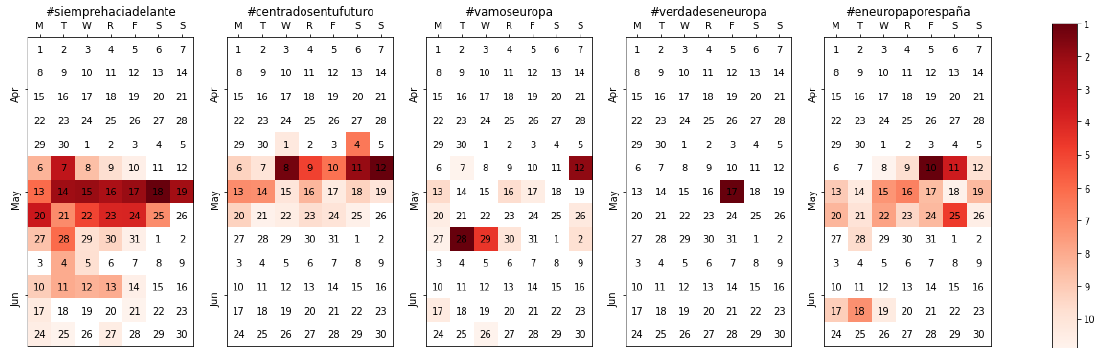
Figure 7. Calendar heatmap for the official slogan per party (top 5 parties) during the European/local elections campaign.